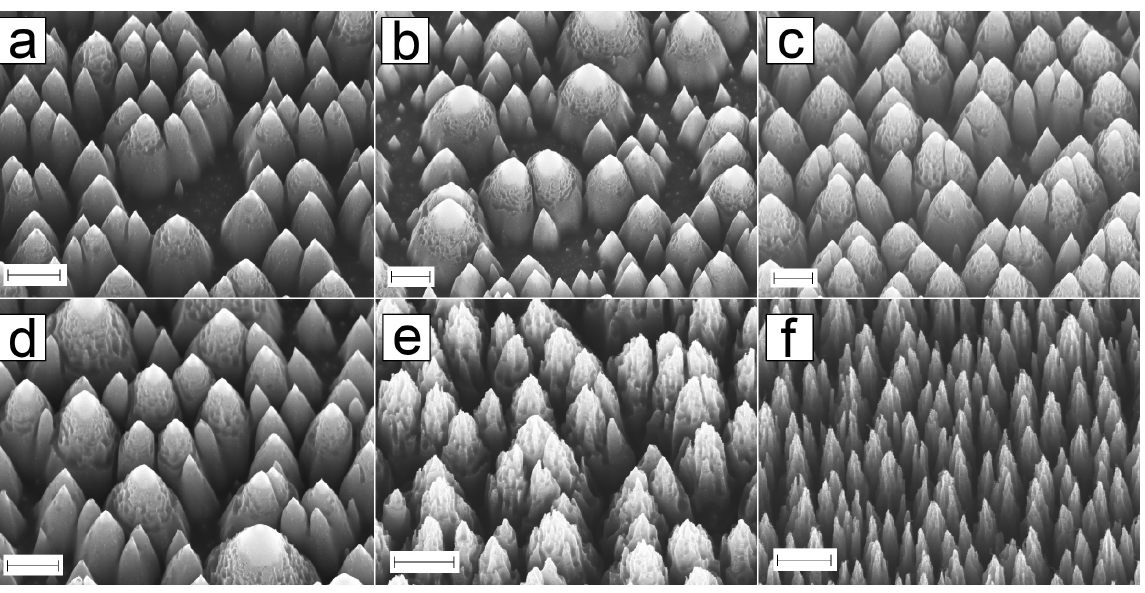
Figure 4. Scanning electron microscope (SEM) images of black silicon structures with variable etching times. Anisotropic etching profile creates sharp pyramid-like structures on silicon. The structures become denser when the etching time is increased from ( a ) 3.5 min to ( b ) 3.75 min. Almost all planar silicon is consumed with etching time of ( c ) 3.875 min. Structure size stays approximately the same when the etching time is ( d ) 4 min, but the surface roughness increases which is clearly visible in ( e ) 5 min. After ( f ) 7 min of etching, the pillar size, density, and roughness reach the maximum surface area. All scalebars: 1 µ